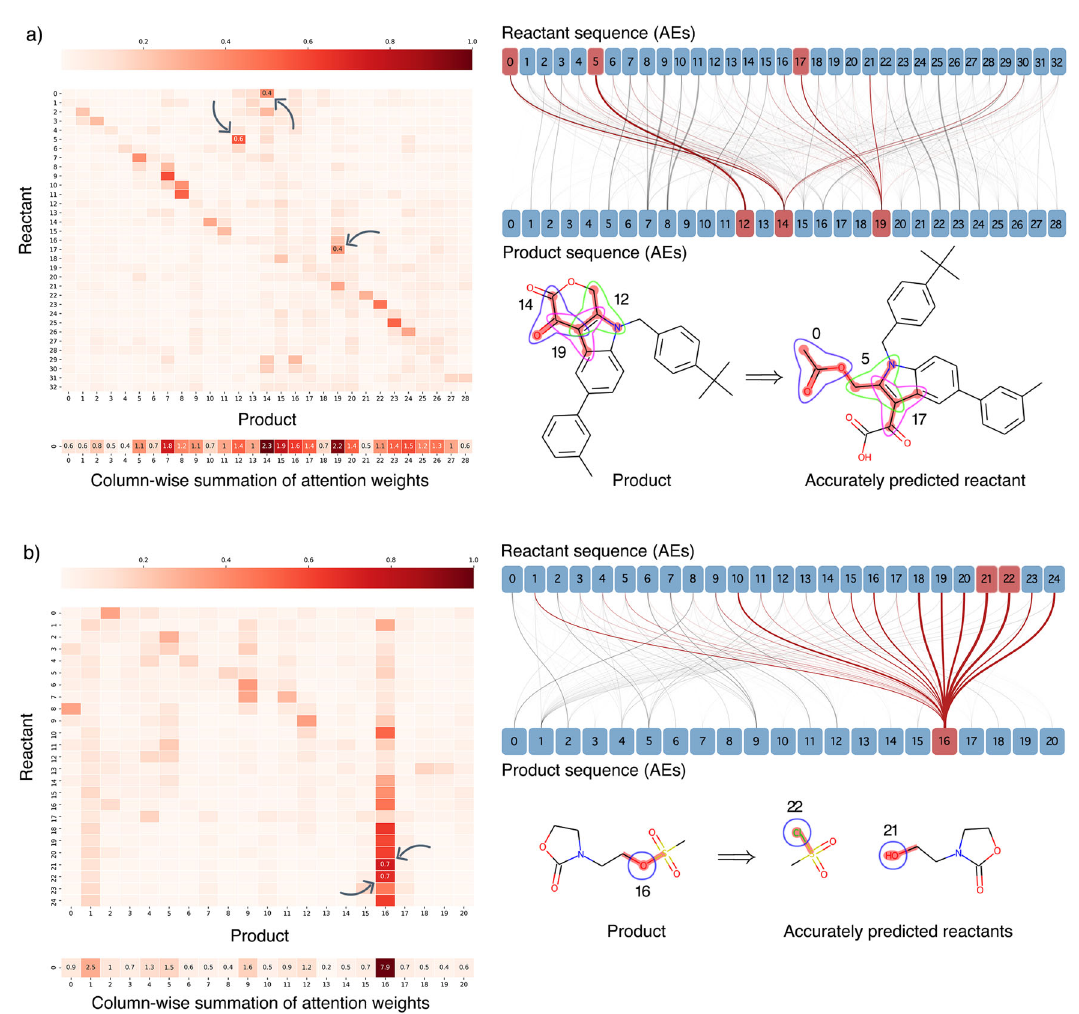
Fig. 3 Visualization of decoder attention and interpretability of RetroTRAE. Attention weight matrices, column-wise attention sums, and attention mappings are displayed for a Uni-molecular ring-opening reaction b Bi-molecular dissociation reaction. The AE pairs with highest attention values correspond to the reaction centers and disconnection sites. Highly correlated AE pairs between reactant and product sequences are visualized in attention maps. The widths of connections are proportional to attention values and the altered AEs surrounding the reaction center with high attention scores are highlighted.